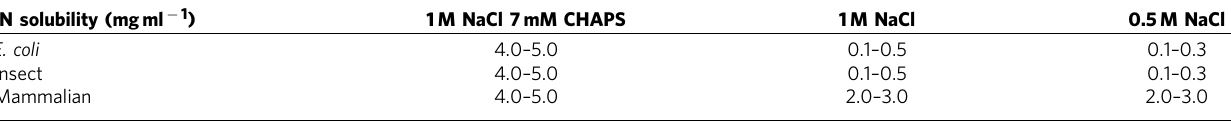
Table 2 | IN solubility was tested in different solvents. IN solubility (mgml (cid:2) 1 )